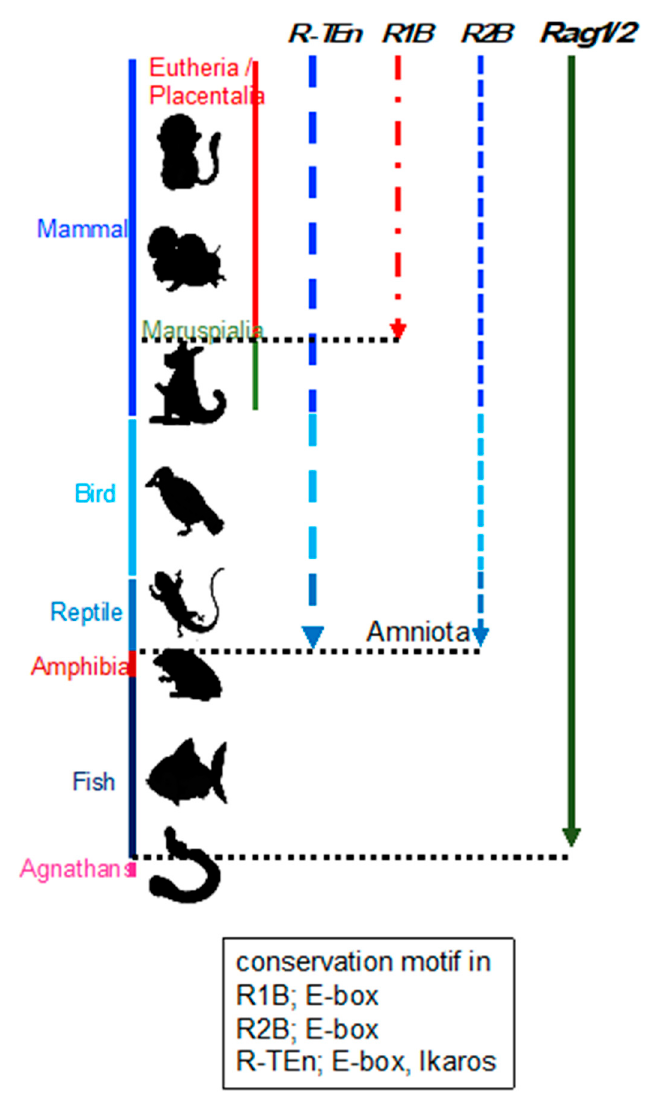
Figure 2. Schematic summary of the conservation of R-TEn , R1B , and R2B among vertebrates. Black, dotted lines indicate the border between placentaria and maruspialia, reptile and amphibia, and fish and agnathans. The conserved motifs in each enhancer region are shown in the box [21].